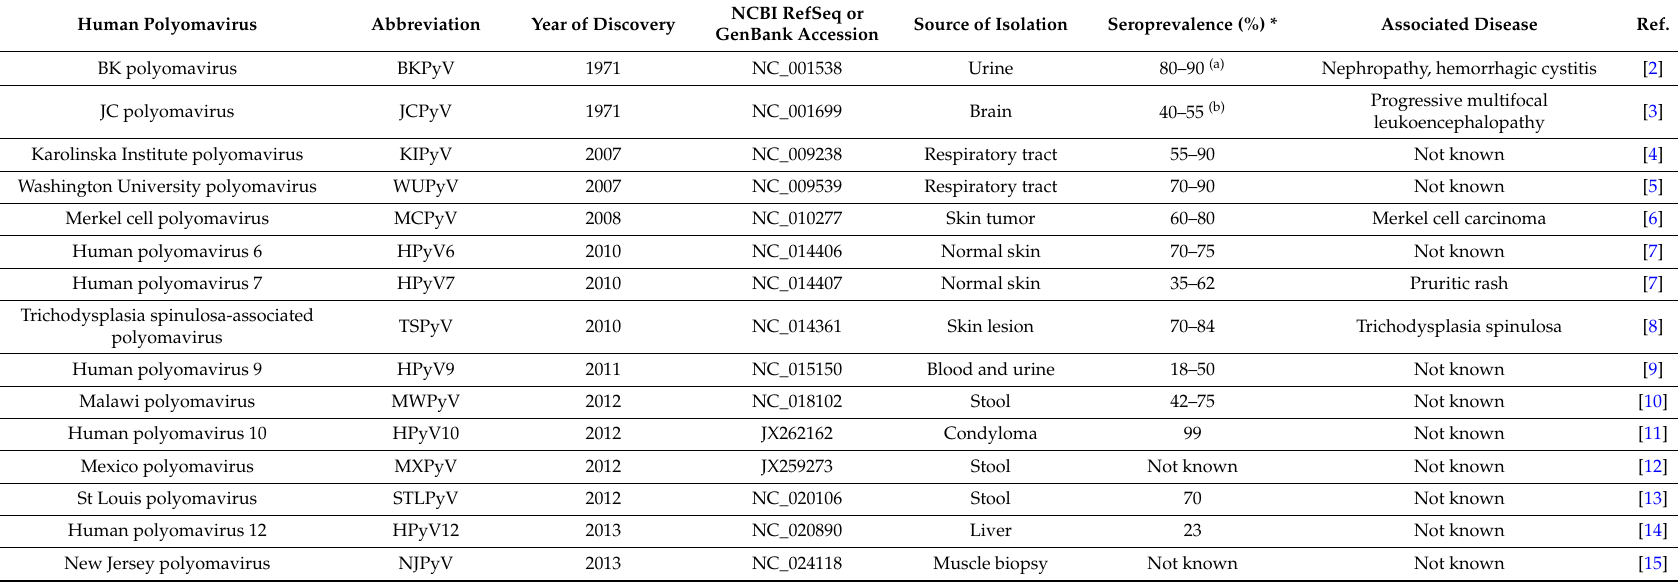
Table 1. Discovery of human polyomaviruses and associated